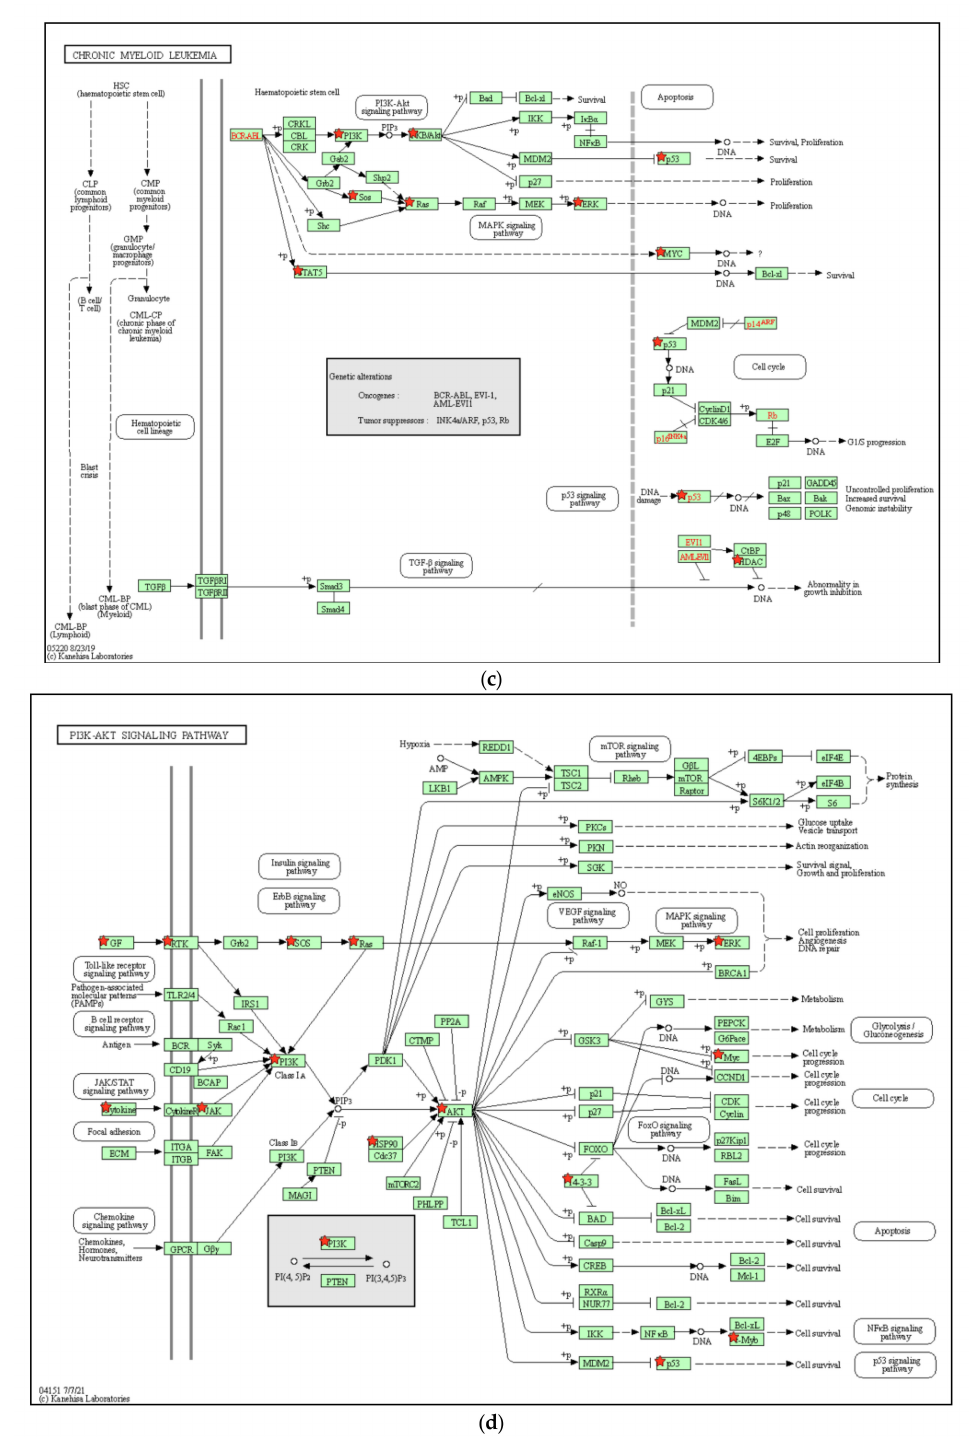
Figure 8. KEGG pathways associated with both 8-OHD-downregulation and myeloid leukemia (ML). ( a ) Venn diagrams demonstrating 112 putative ML targets downregulated by 8-OHD. ( b ) Bubble chart indicates the top 15 enriched KEGG pathways by 112 targets. Gene counts are indicated by the bubble size and number inside. ( c ) KEGG “Chronic myeloid leukemia pathway” (hsa05220) associated with 8-OHD-downregulated and ML genes. ( d ) KEGG “PI3K-Akt signaling pathway” (hsa04151) associated with 8-OHD-downregulated and ML genes. Green box indicates that map objects exist and are linked to corresponding entries. Downregulated genes obtained from microarray are indicated by red star